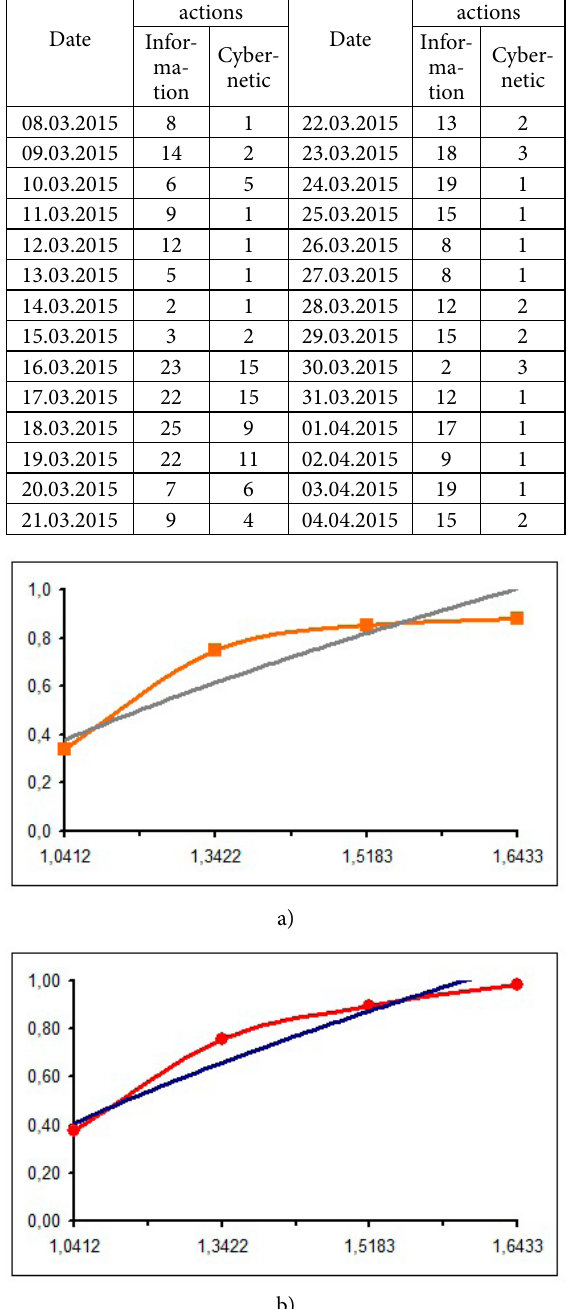
Fig. 5. Results of the R S – analysis: (a) – information actions; (b) – cybernetic actions N